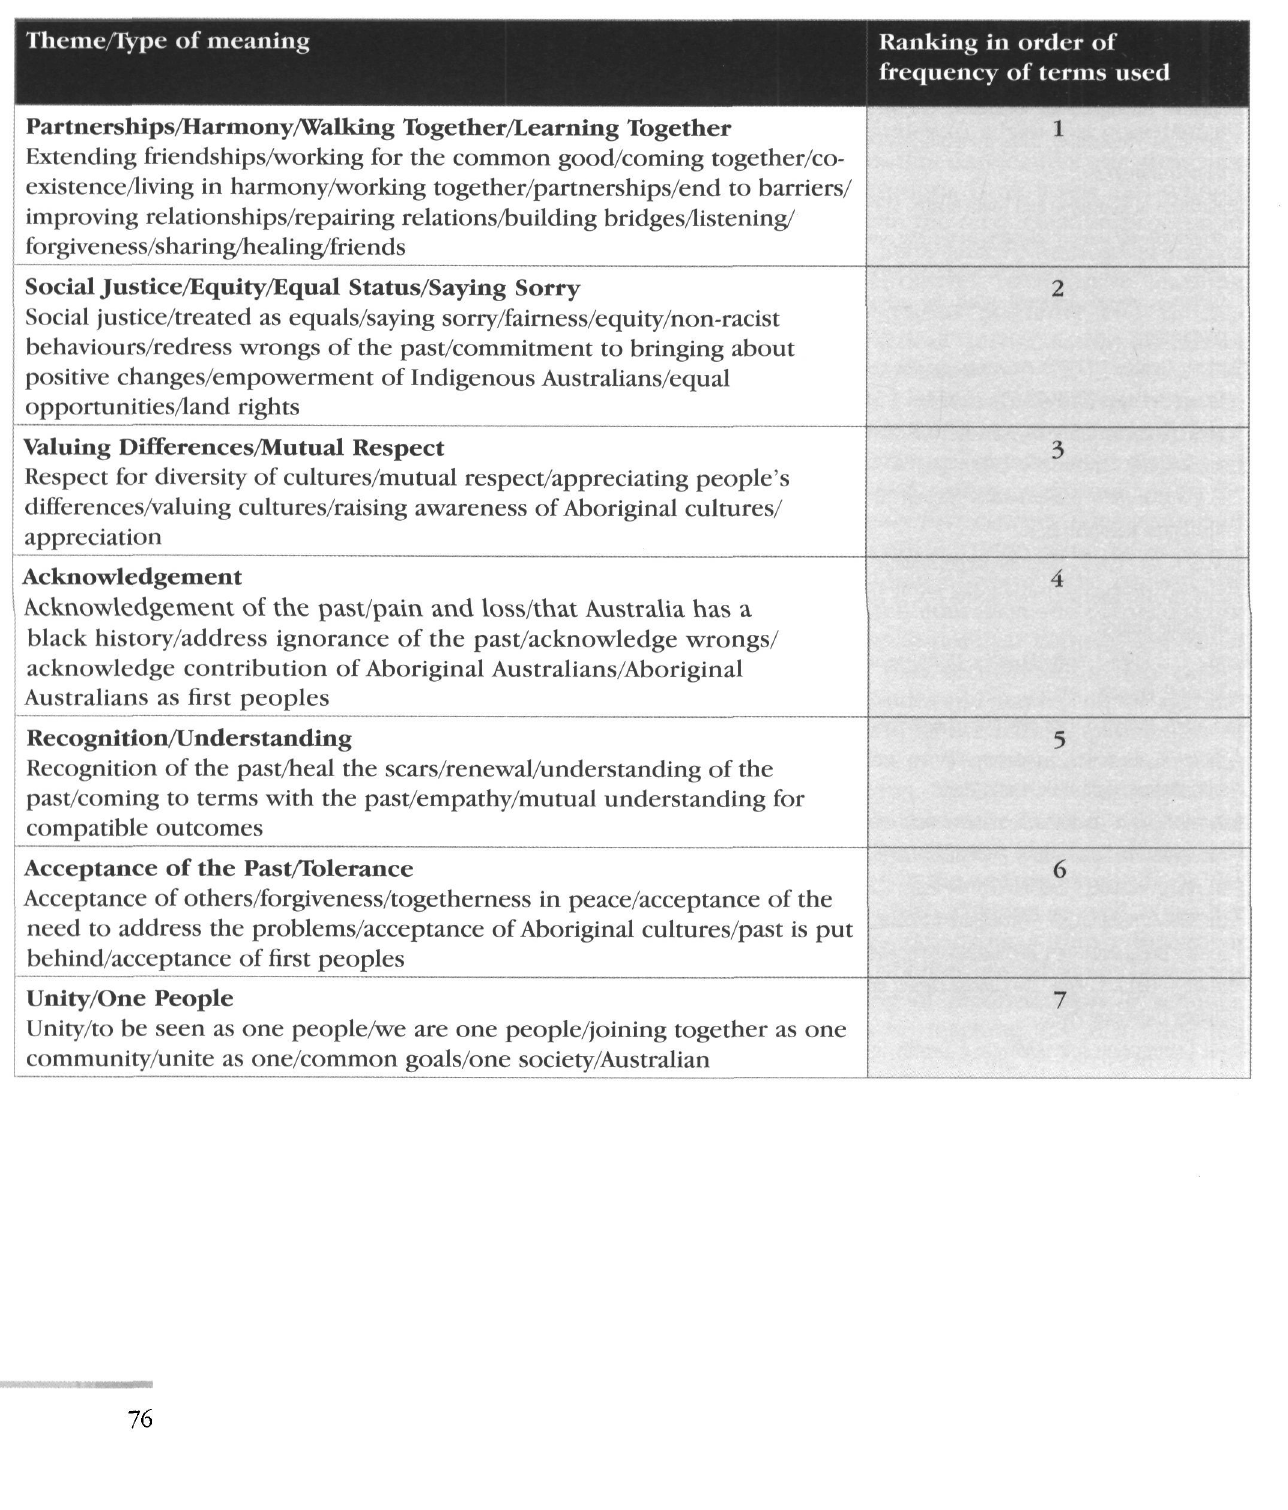
frequency of terms